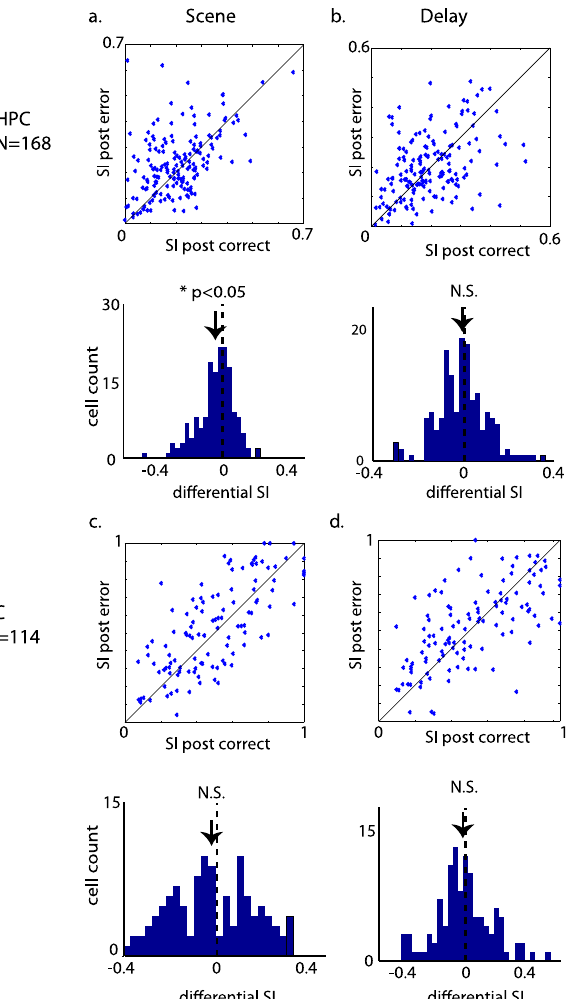
Fig. 2 Illustration of selectivity index (SI) immediately after error trials versus after correct trials. a , b The SI during scene and delay period in HPC. c , d The SI during scene and delay period in EC. The distribution of differential selectivity index (after correct — after error) is also plotted below each scatter plot. During the scene period in HPC the SI after error trials is signi fi cantly higher than after correct trials ( t (166) = 2.405, p = 0.0173, paired t -test). All data points are shown in Supplementary Data